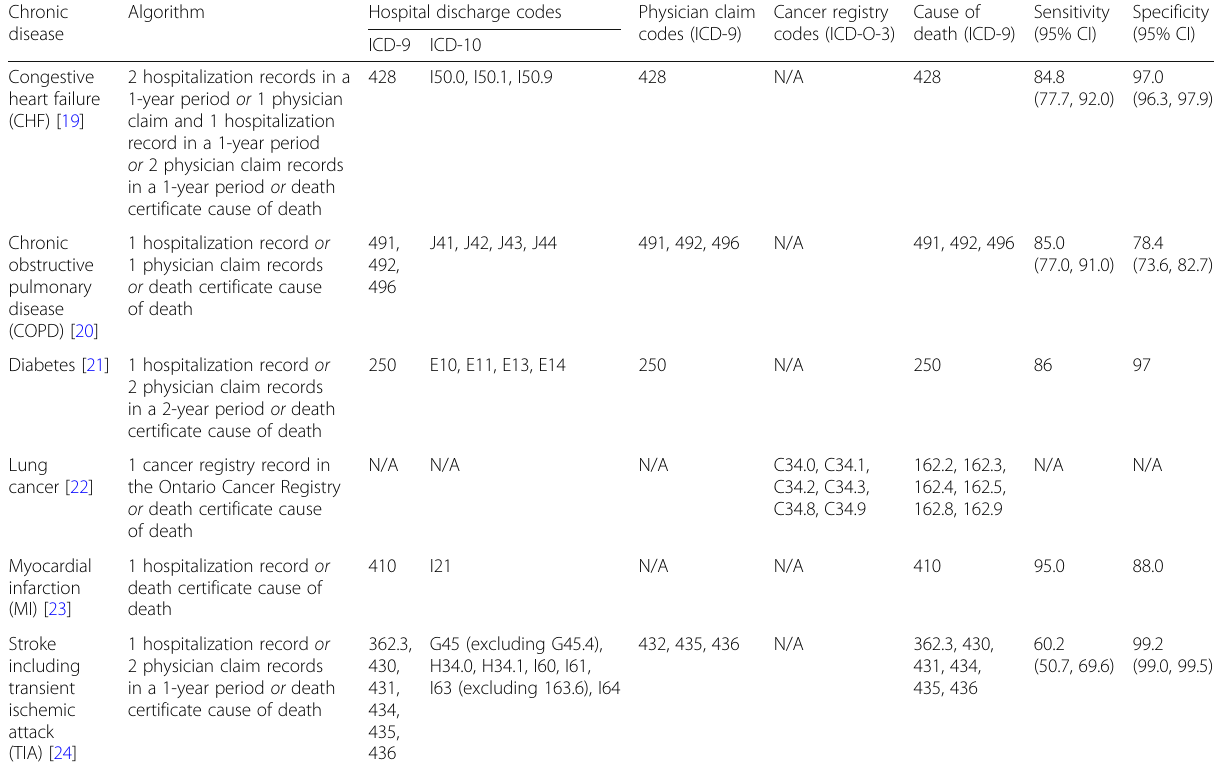
Table 1 Chronic disease ascertainment algorithms and their predictive accuracy Chronic disease